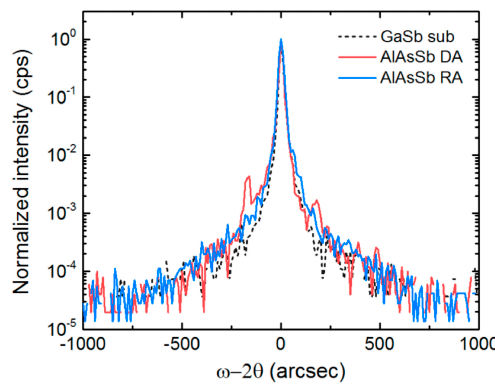
Figure 1. HRXRD ω -2 θ scans for the AlAsSb DA and RA samples. The ω -2 θ scan of the GaSb substrate is also shown as a reference.